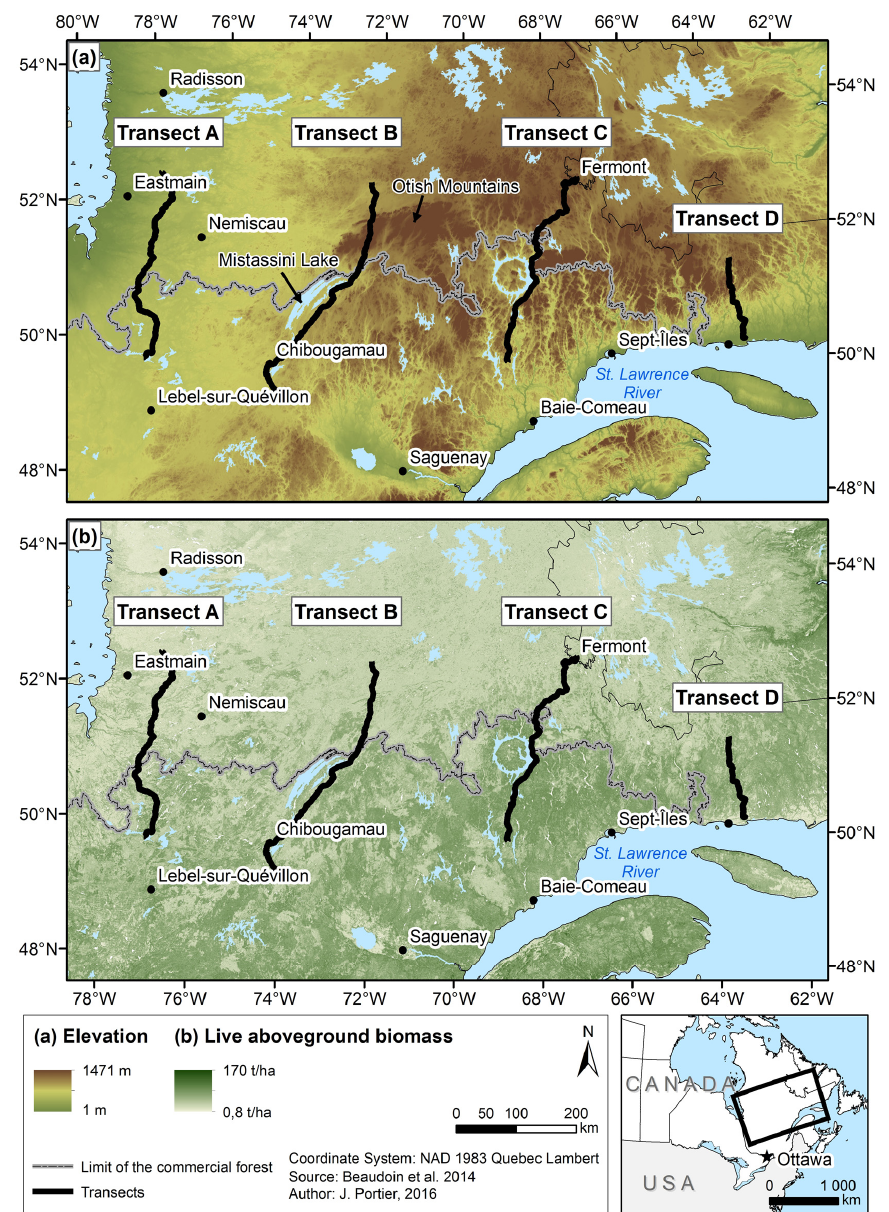
Figure 1. Maps of the study area showing the four transects being analyzed, along with ( a ) the elevation profile and ( b ) the live aboveground biomass in tons per hectare from Beaudoin et al. [34] of the study area. The northern limit of the commercial forest in Quebec is also